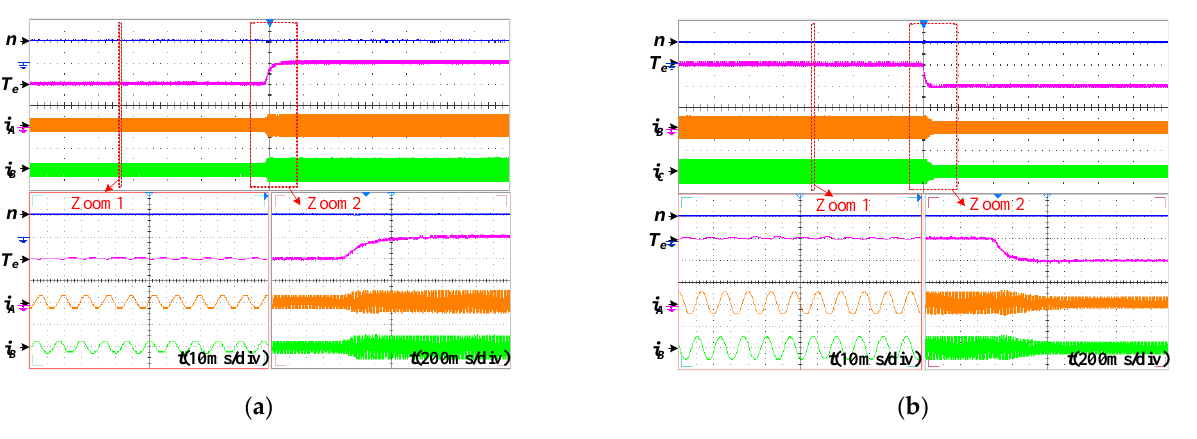
Figure 7. Dynamic responses with the changed load in healthy operation for the proposed FOC (500 rpm/div, 2 Nm/div, 5 A/div). ( a ) Increased load. ( b ) Reduced